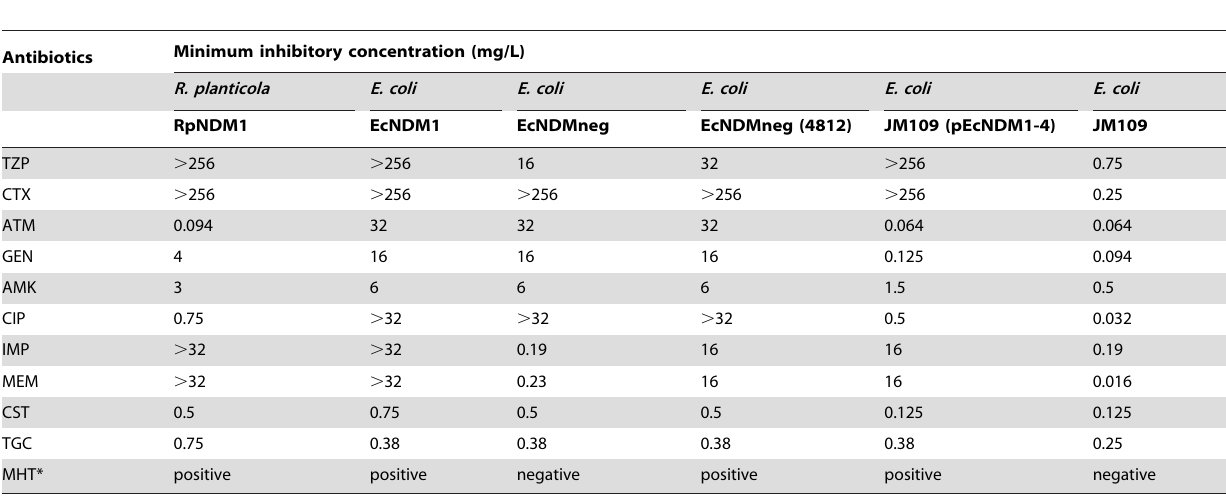
Table 1. Antimicrobial susceptibility patterns of R. planticola KpNDM1, E. coli EcNDMneg, E. coli EcNDM1-4 and their